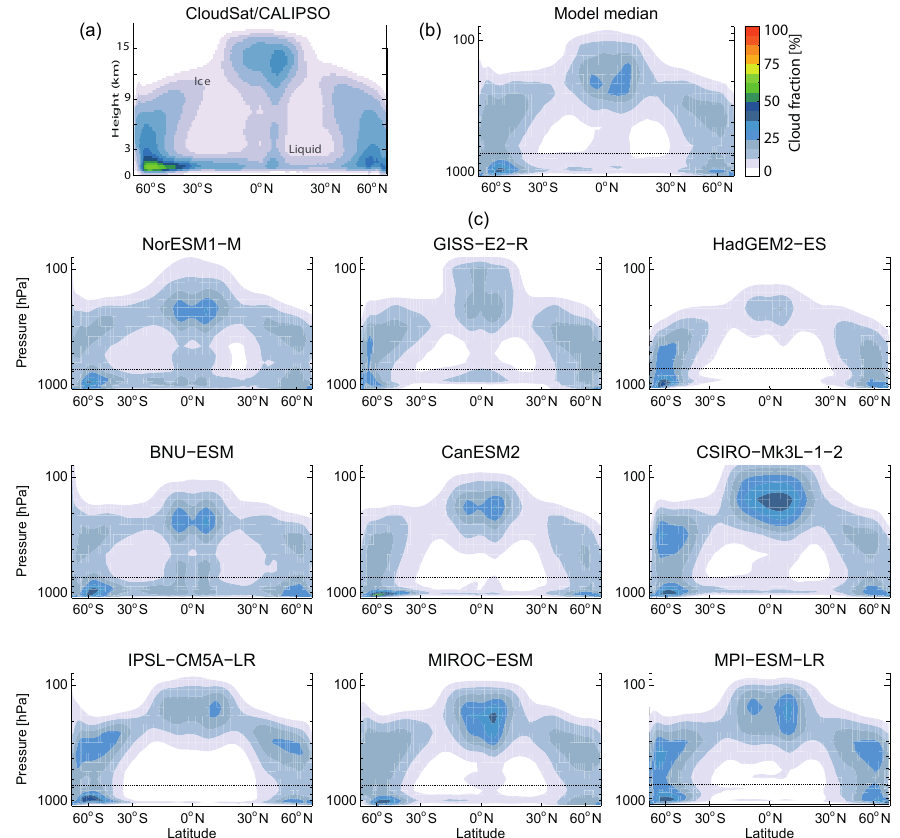
Figure 1. Panel (a) shows cloud fraction (%) from CloudSat/CALIPSO, adapted from Fig. 7.5c of Boucher et al. (2013) with permission. Panel (b) shows the GeoMIP model median for the first 20 years of the RCP4.5 scenario, and panels in (c) show individual RCP4.5 GeoMIP model results for the same years. Note different vertical axes for the AR5 and GeoMIP